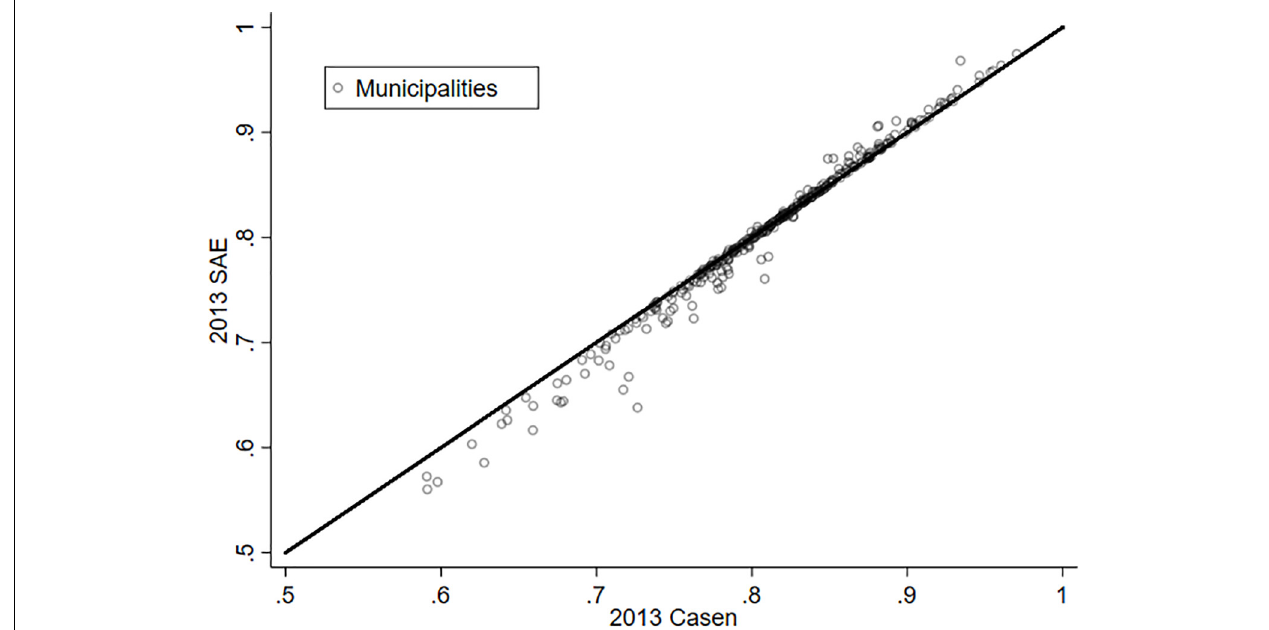
FIGURE 3 | Life satisfaction and SAE for the proportion of people who are satisfied with their lives, 2013.